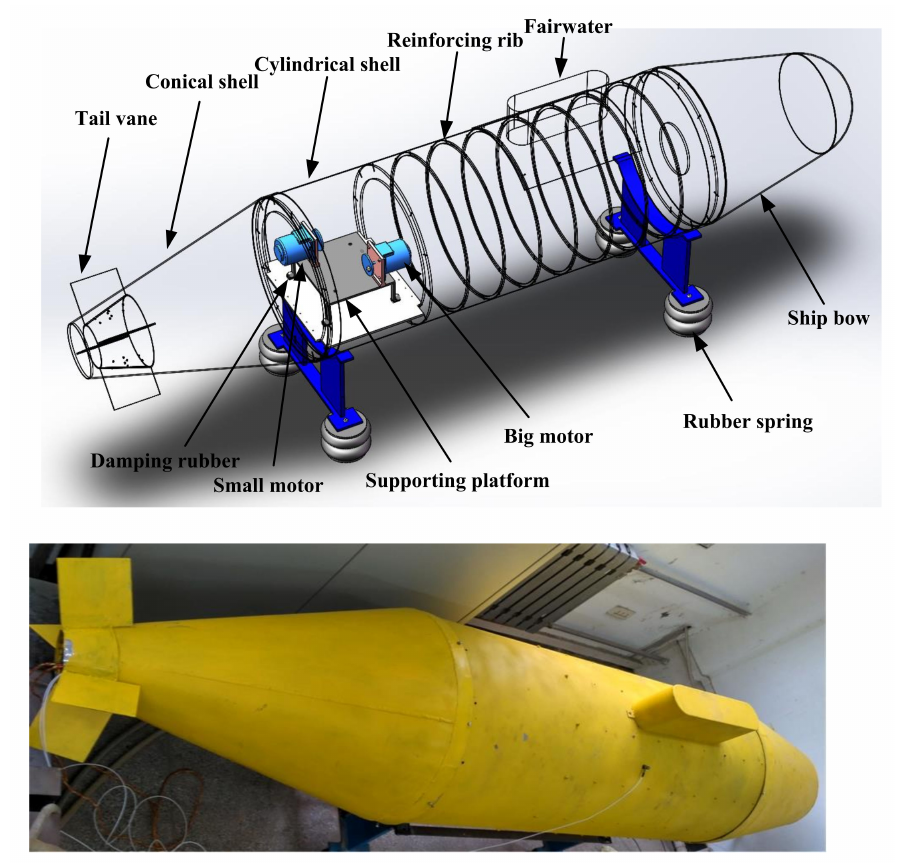
Figure 21. Composite structure shell test bed.